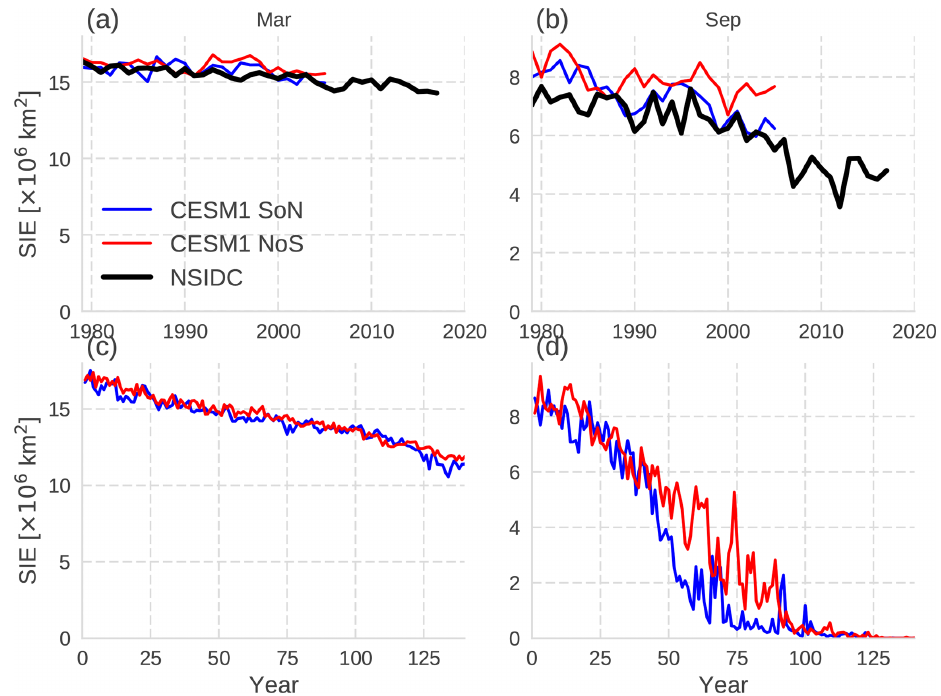
Figure 2. Observed (black) CESM1-CAM5-simulated Arctic sea ice extent in (a) March using the protocol CMIP5 historical simulation, (b) September in the historical simulation, (c) March in 1pctCO2 and (d) September in 1pctCO2. Blue lines are with snow radiative effects (SoN) and red without